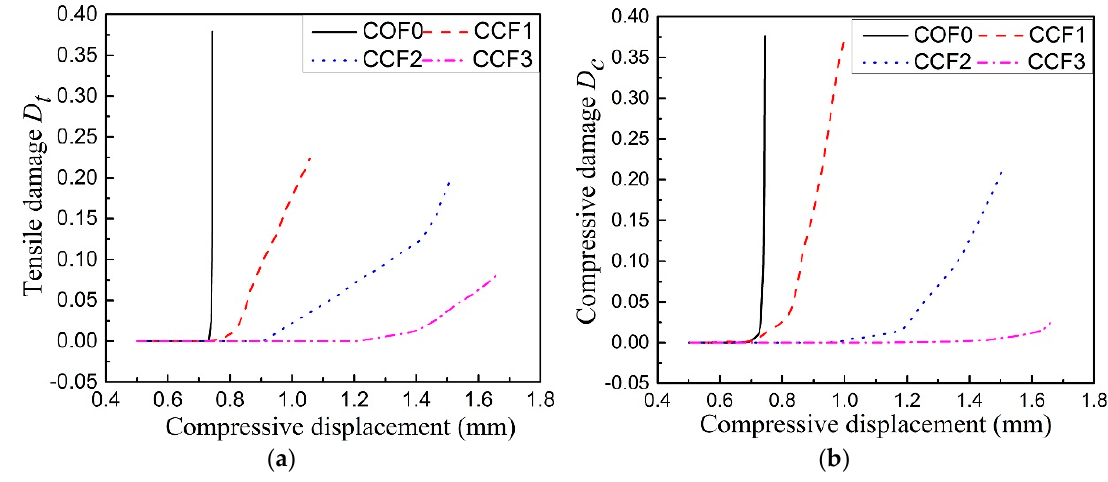
Figure 16. The maximum damages of the cross sections of the vertically placed cell edges under different compressive displacements: ( a ) compressive damages; ( b ) tensile damages.